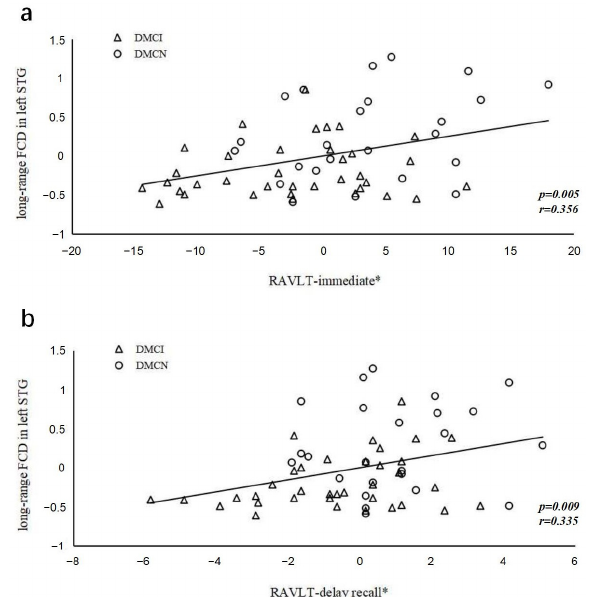
Figure 5. The correlations between RAVLT scores and long-range FCD in the left superior temporal gyrus. ( a ) Correlation between Z-scores of FCDs in the left superior temporal gyrus and the RAVLT immediate scores ( r = 0.356, p = 0.005); ( b ) Correlation between Z-scores of FCDs in the left superior temporal gyrus and the RAVLT delayed recall scores ( r = 0.335, p = 0.009). The asterisk (*) indicates coordinate values, controlling for effects of years of education.